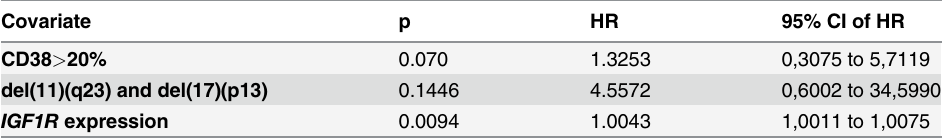
Table 3. Cox multivariate analysis results considering only IGHV-M CLL patients. Covariate p HR 95% CI of HR CD38 > 20% 0.070 1.3253 del(11)(q23) and